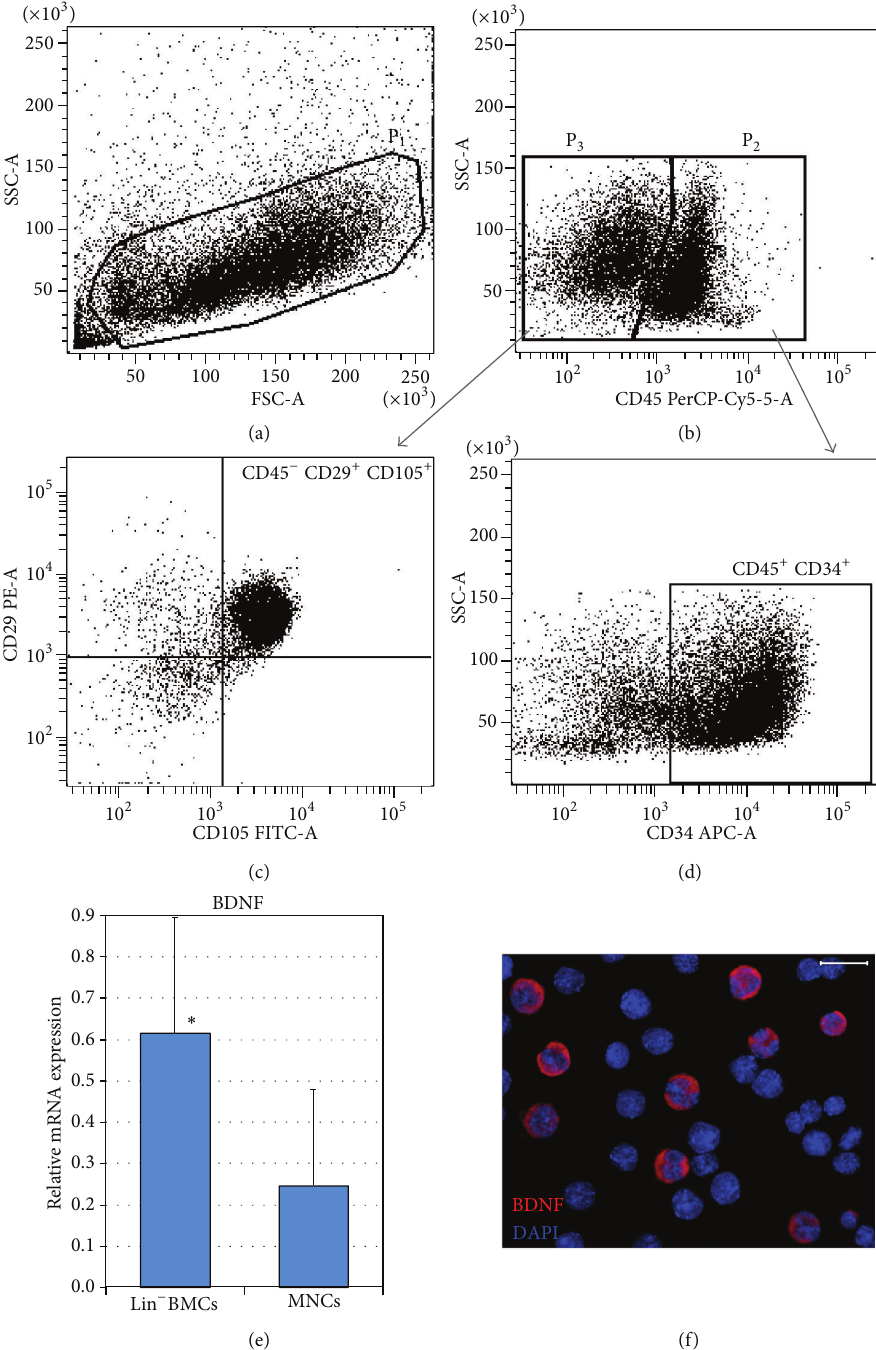
Figure 1: Quantification of the hematopoietic and mesenchymal origin of a BM-derived Lin − cell population by flow cytometry. Lin − BMC distribution based on FSC (Forward Scatter) and SSC (Side Scatter) parameters that describe their size and granularity, respectively (a). The cells enclosed in region P1 were further subdivided into hematopoietic (region P2) or nonhematopoietic (region P3) cell populations based on their CD45 antigen expression (b). CD45 − BMCs were additionally analyzed based on their CD29 and CD105 antigen expression to determine their mesenchymal origin (c). Similarly, CD45 + BMCs were analyzed according to their CD34 antigen expression to exclude mature hematopoietic cells and to determine the number of hematopoietic stem/progenitor cells (d). Expression of mRNA for BDNF in isolated Lin − BMCs and BM-derived mononuclear cells (e). Immunocytofluorescence image of Lin − BMCs depicts the expression of BDNF protein (red). Nuclei are visualized with DAPI staining (blue) (f). Scale bar = 20 𝜇 m. ∗ 𝑃 < 0.05